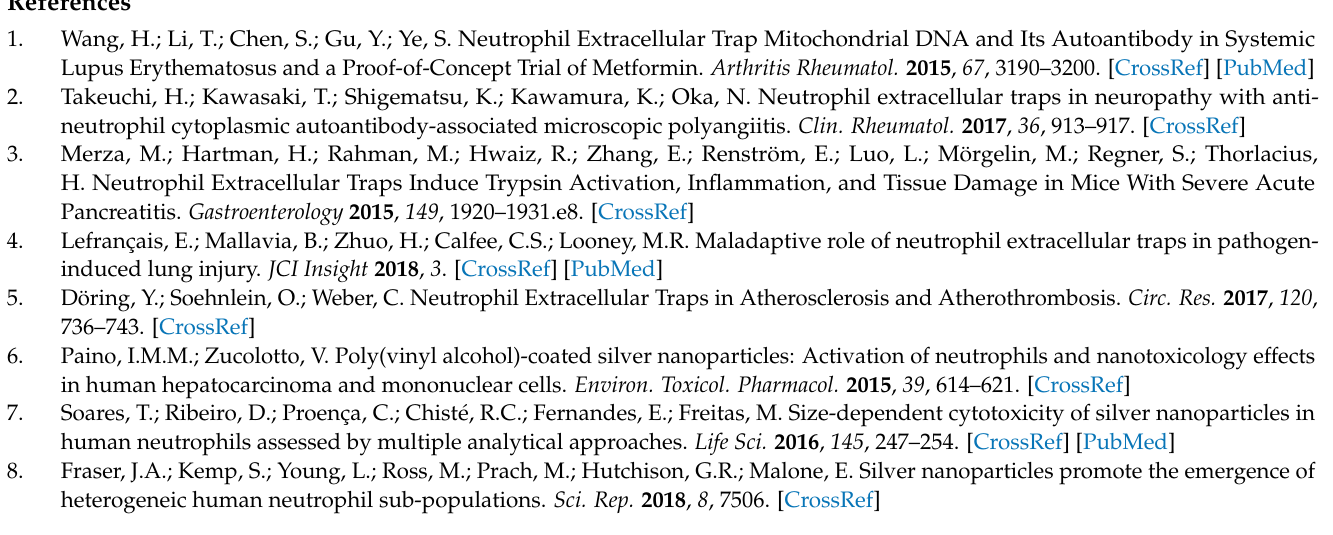
Figure S3: Cytotoxicity of AgNPs in human neutrophils. Table S1: PCR primers used in this